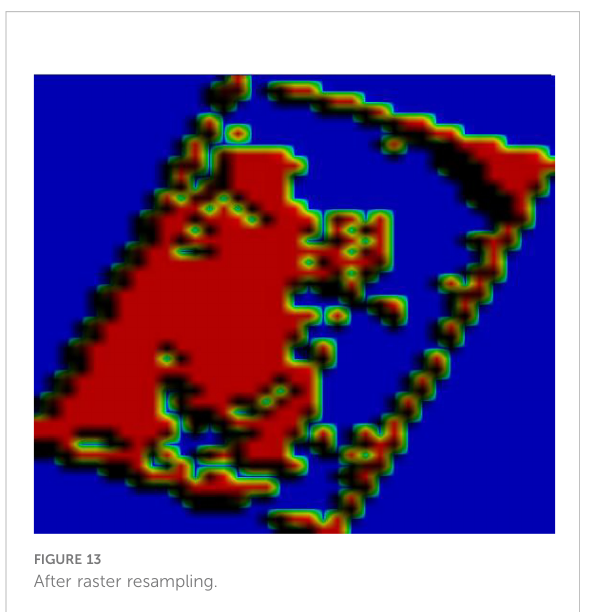
FIGURE 13 After raster